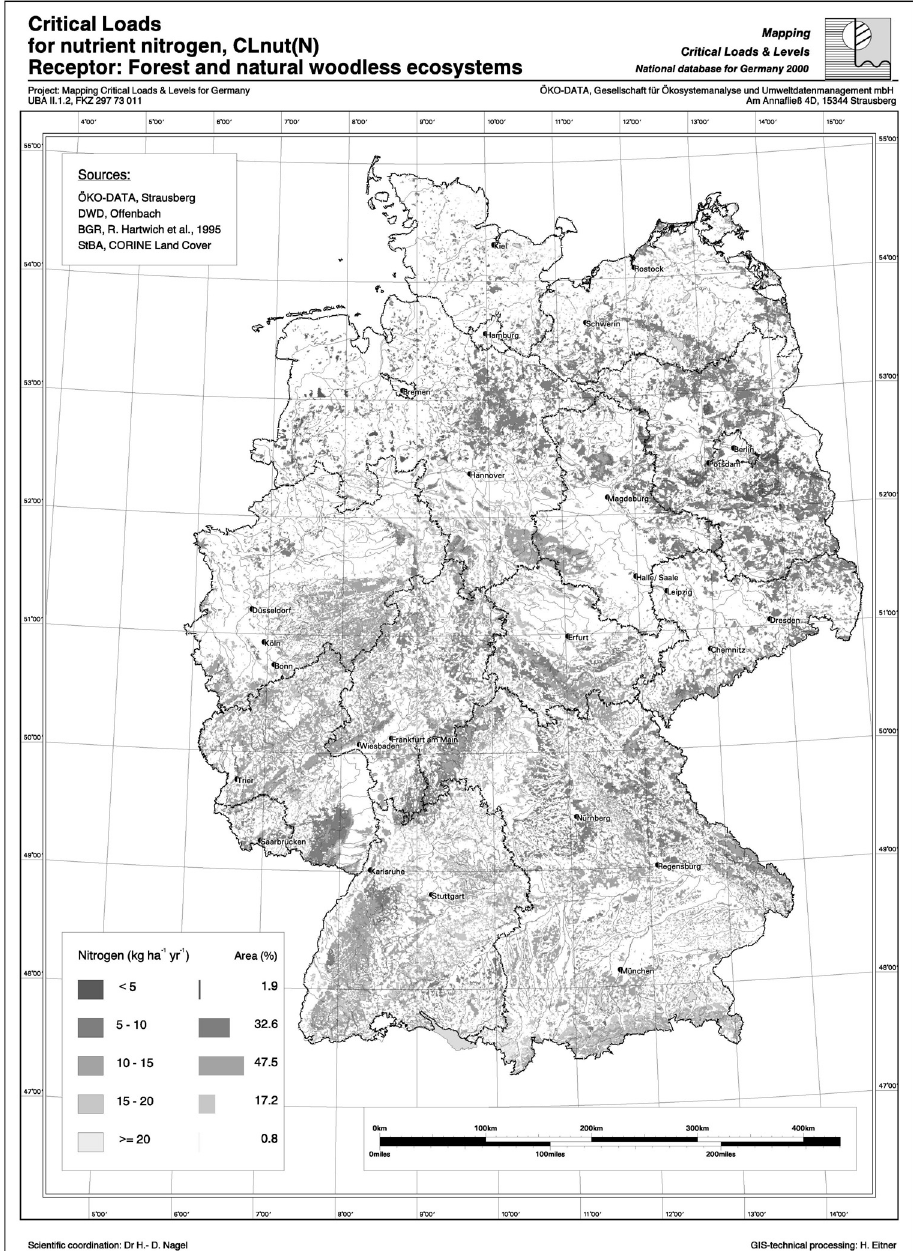
FIGURE 7 . Regional distribution of critical loads for nutrient